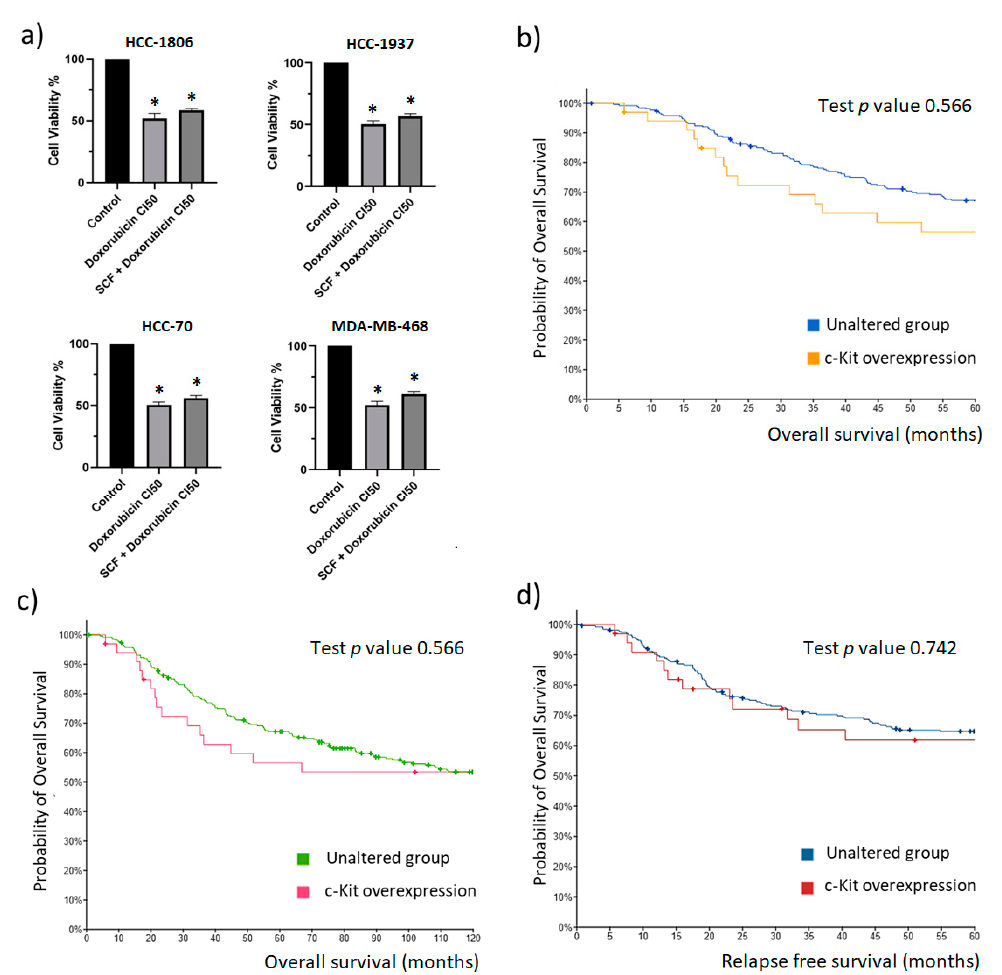
Figure 4. Effect of c-Kit activation on the cytotoxic activity of Doxorubicin. ( a ) HCC-1806, HCC- 1937, HCC-70, and MDA-MB-468 cells were pre-incubated with 100 ng/mL SCF and then treated with the calculated IC50 of Doxorubicin. Cell viability was measured after 48 h by the colorimetric MTT assay. The values represent the average of three independent experiments. The error bars indicate the standard error of the mean. * p < 0.05 vs. the untreated control values (Dunnett test). ( b ) The association of tumor c-Kit overexpression with 5-year overall survival of TNBC patients was explored using METABRIC datasets. ( c ) The association of c-Kit overexpression with 10-years overall survival. ( d ) The association of c-Kit overexpression with the level of 5-year relapse-free survival. Statistical comparison of samples with c-Kit overexpression and tumors with unaltered expression of c-Kit is presented. Standardized survival data of the METABRIC cohort (unaltered c-Kit expression N = 264; c-Kit overexpression N = 33) were downloaded from the cBioPortal